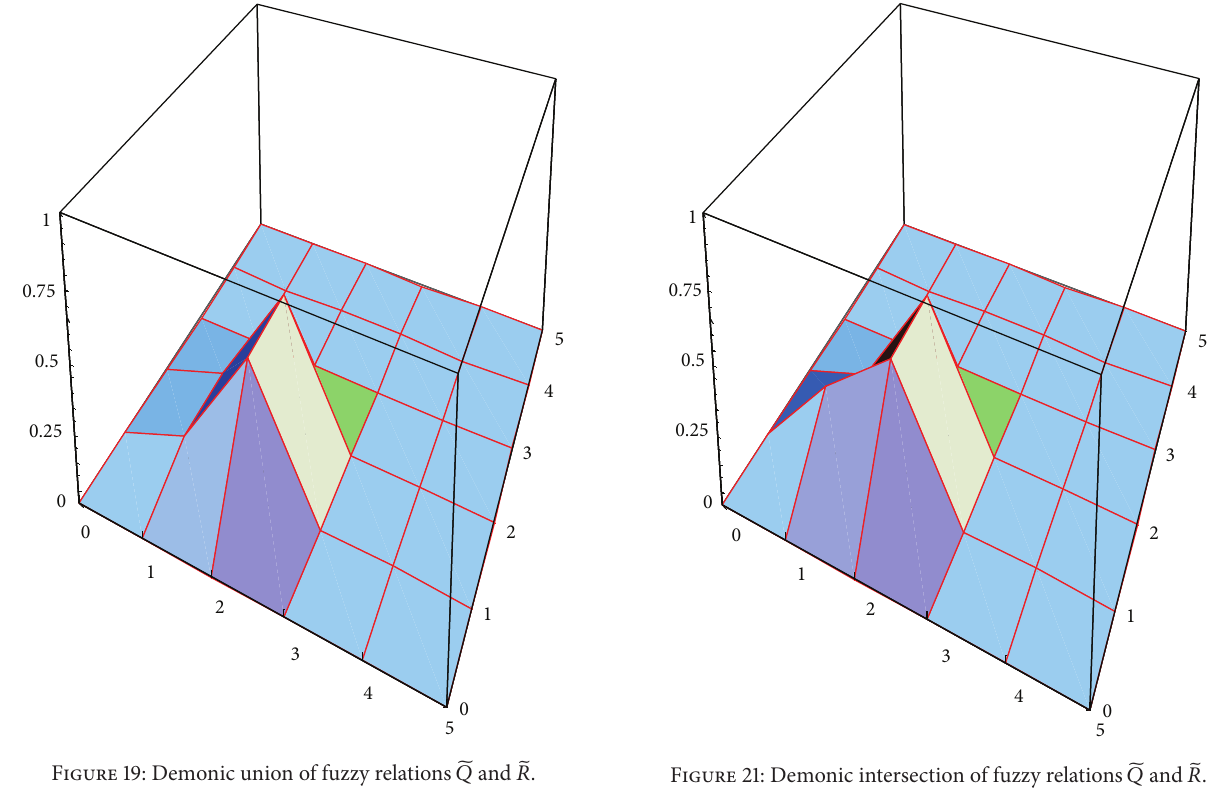
Figure 21: Demonic intersection of fuzzy relations